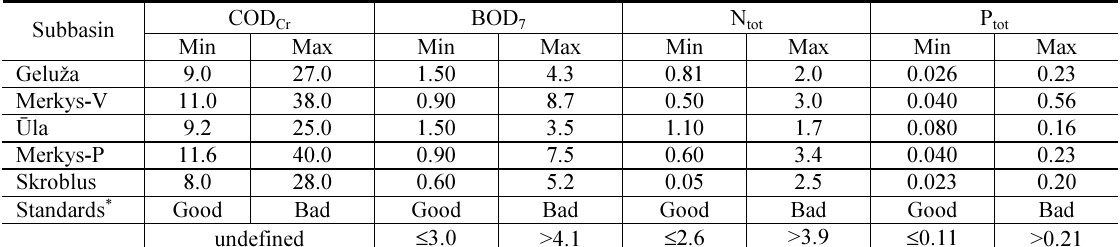
Table 3. Observed riverine concentrations of water quality constituents at sampling sites (mg l –1